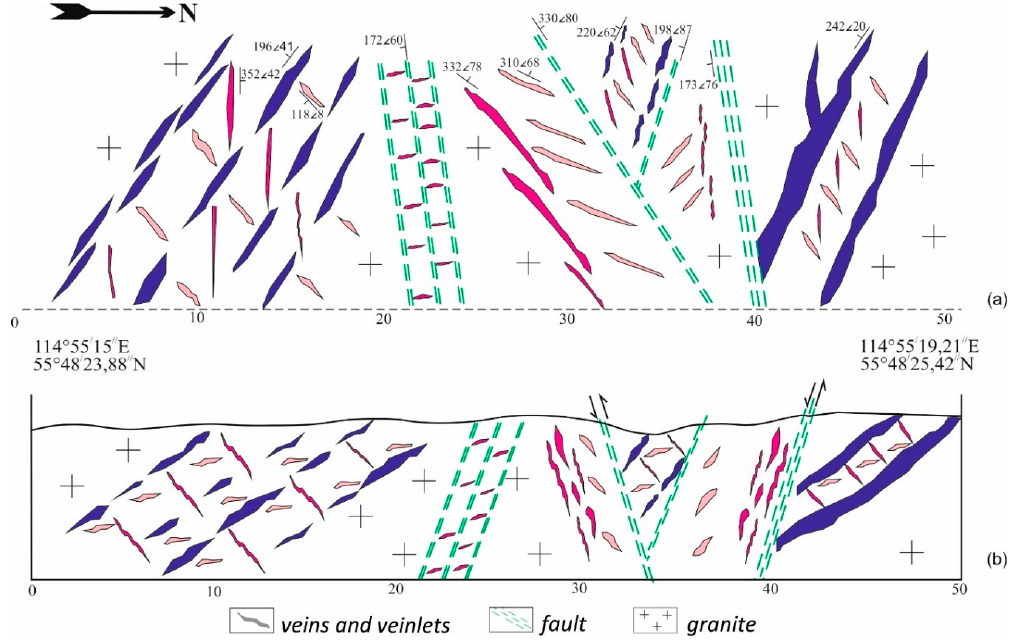
Figure 2. The structure of the quartz veins of the Krivoy zone: ( a ) Plan view; and ( b ) S–N profile. Blue color indicates the main veins, peach and pink indicates syndeformational veins.